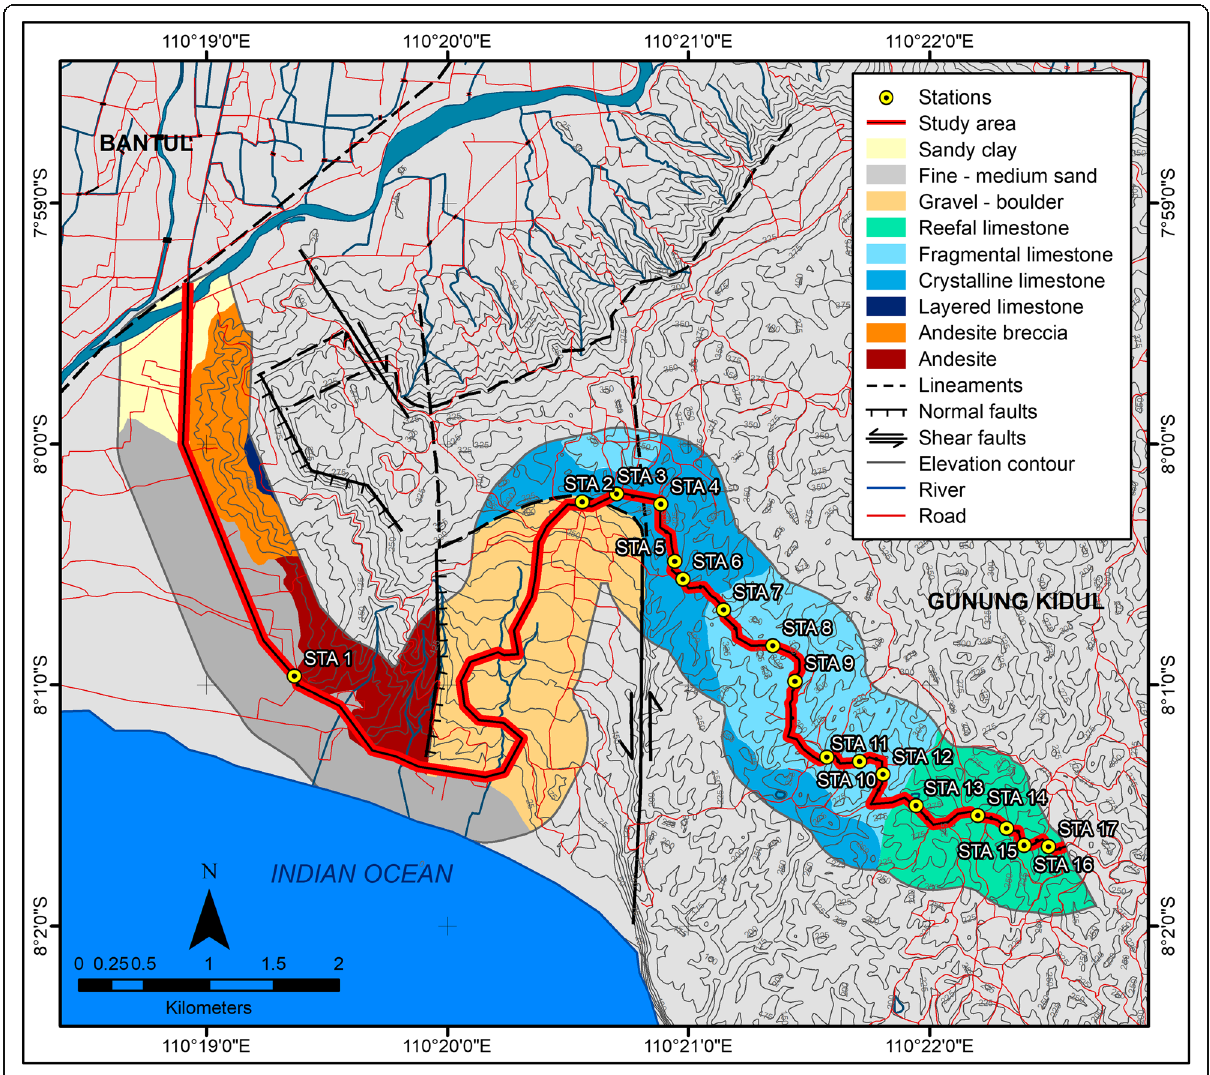
RQD values. Table 13 shows the details of indirect RQD measurements in the study area.